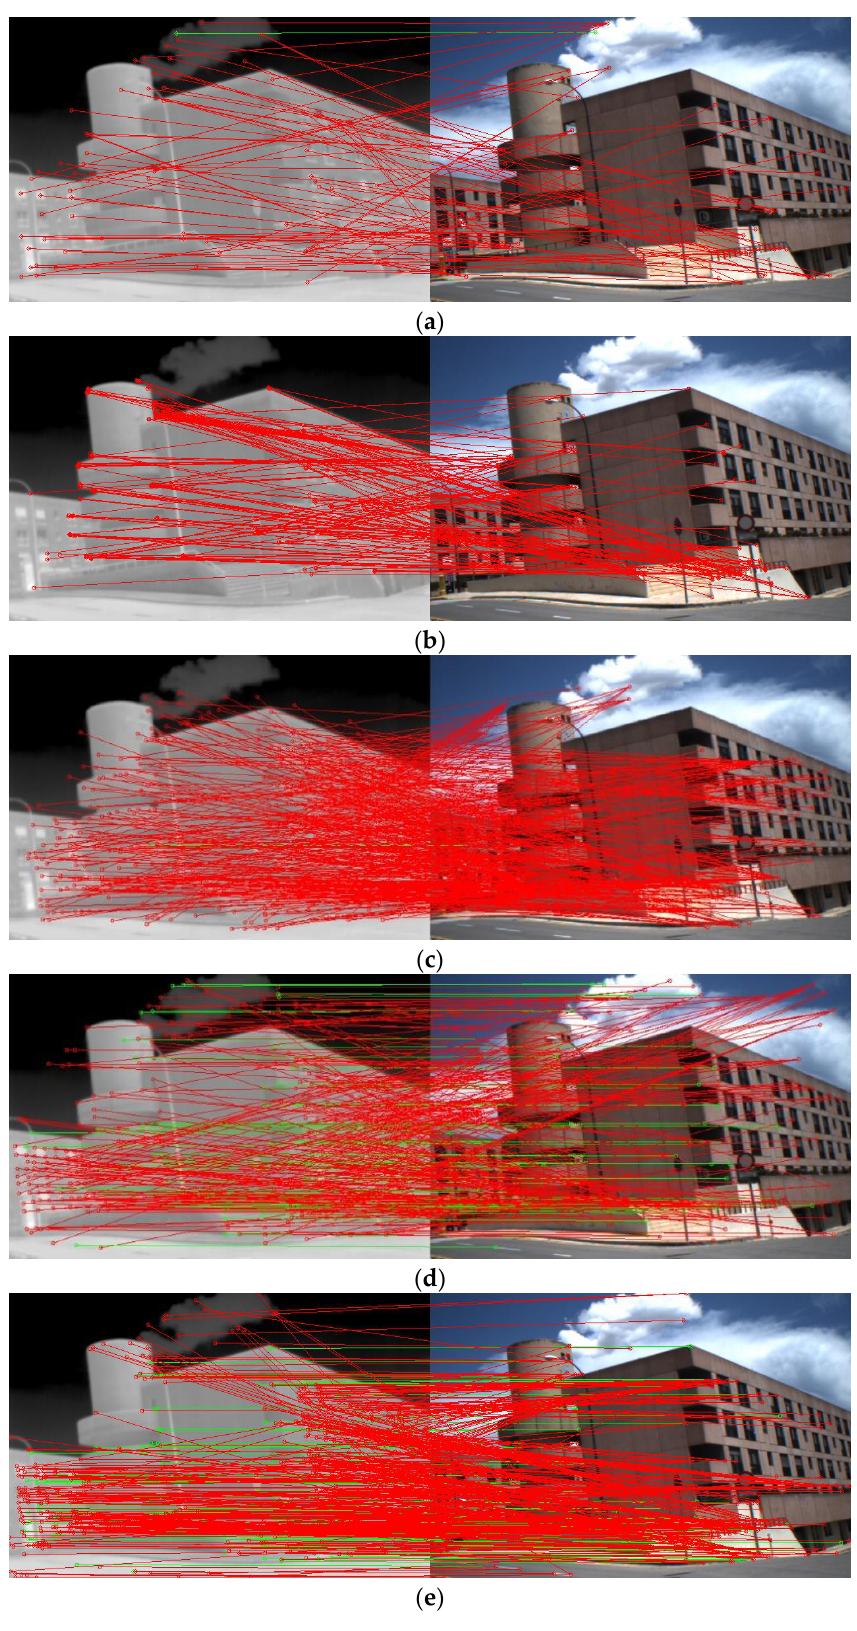
Figure 4. Matching result comparison with single-modality image matching methods. ( a ) SIFT, ( b ) ORB, ( c ) LIFT, ( d ) SuperPoint, and ( e ) DDCE. Red lines indicate the wrong matches and green lines indicate correct matches.